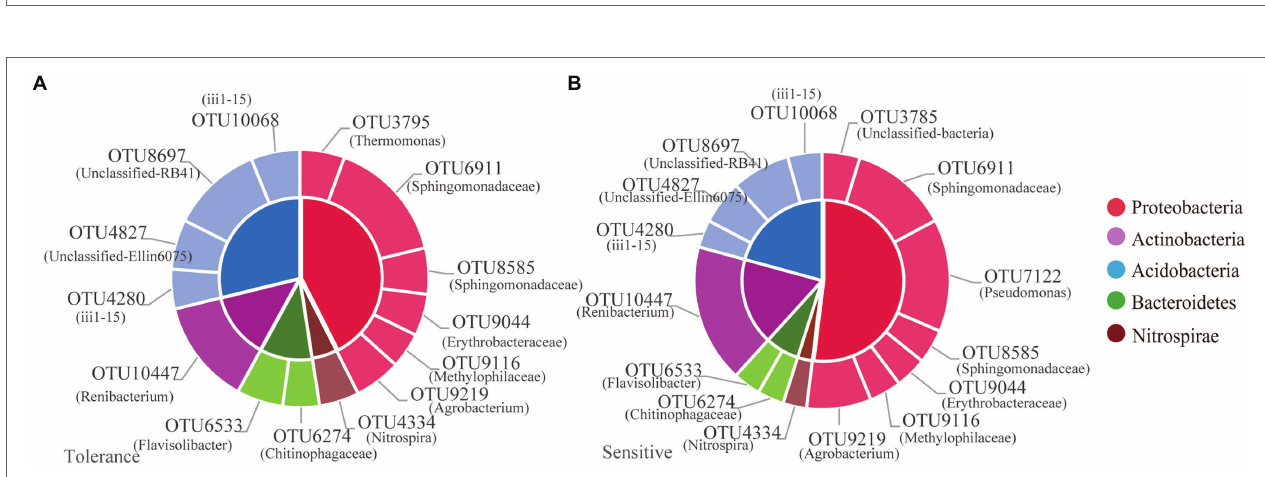
FIGURE 5 | The relative abundance of the core microbiome for tolerant (A) and sensitive (B)